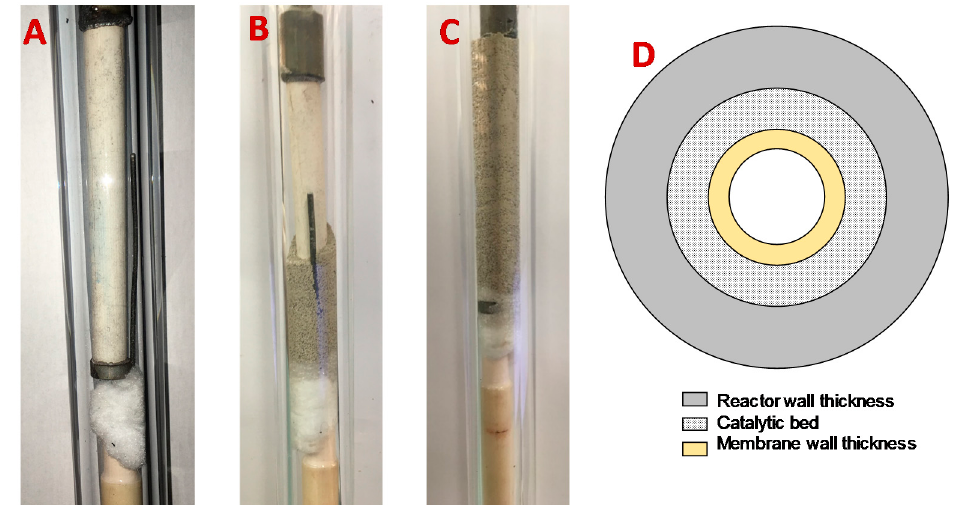
Figure 4. Pictures of the membrane reactor without catalyst ( A ), when part of the catalyst was placed ( B ), and when the catalytic bed was completed ( C ), and the scheme of the view of the reactor in cross-section ( D ).